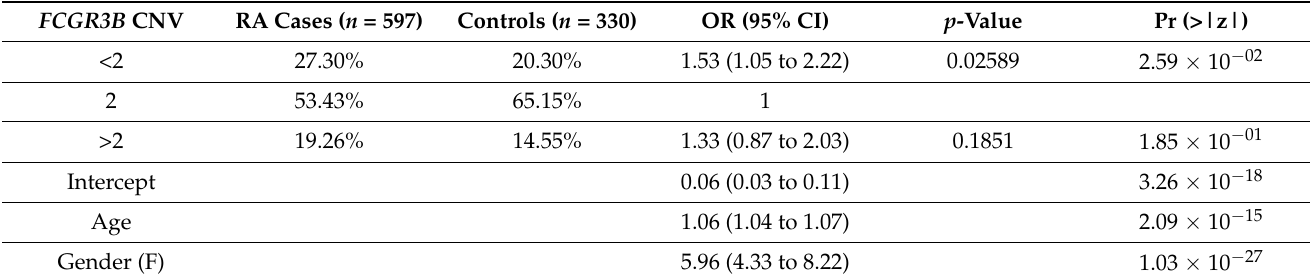
Table 1. Association results of FCGR3B CNV with RA susceptibility.